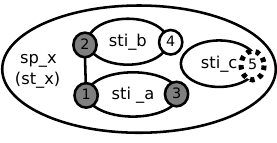
Figure 11: An example of